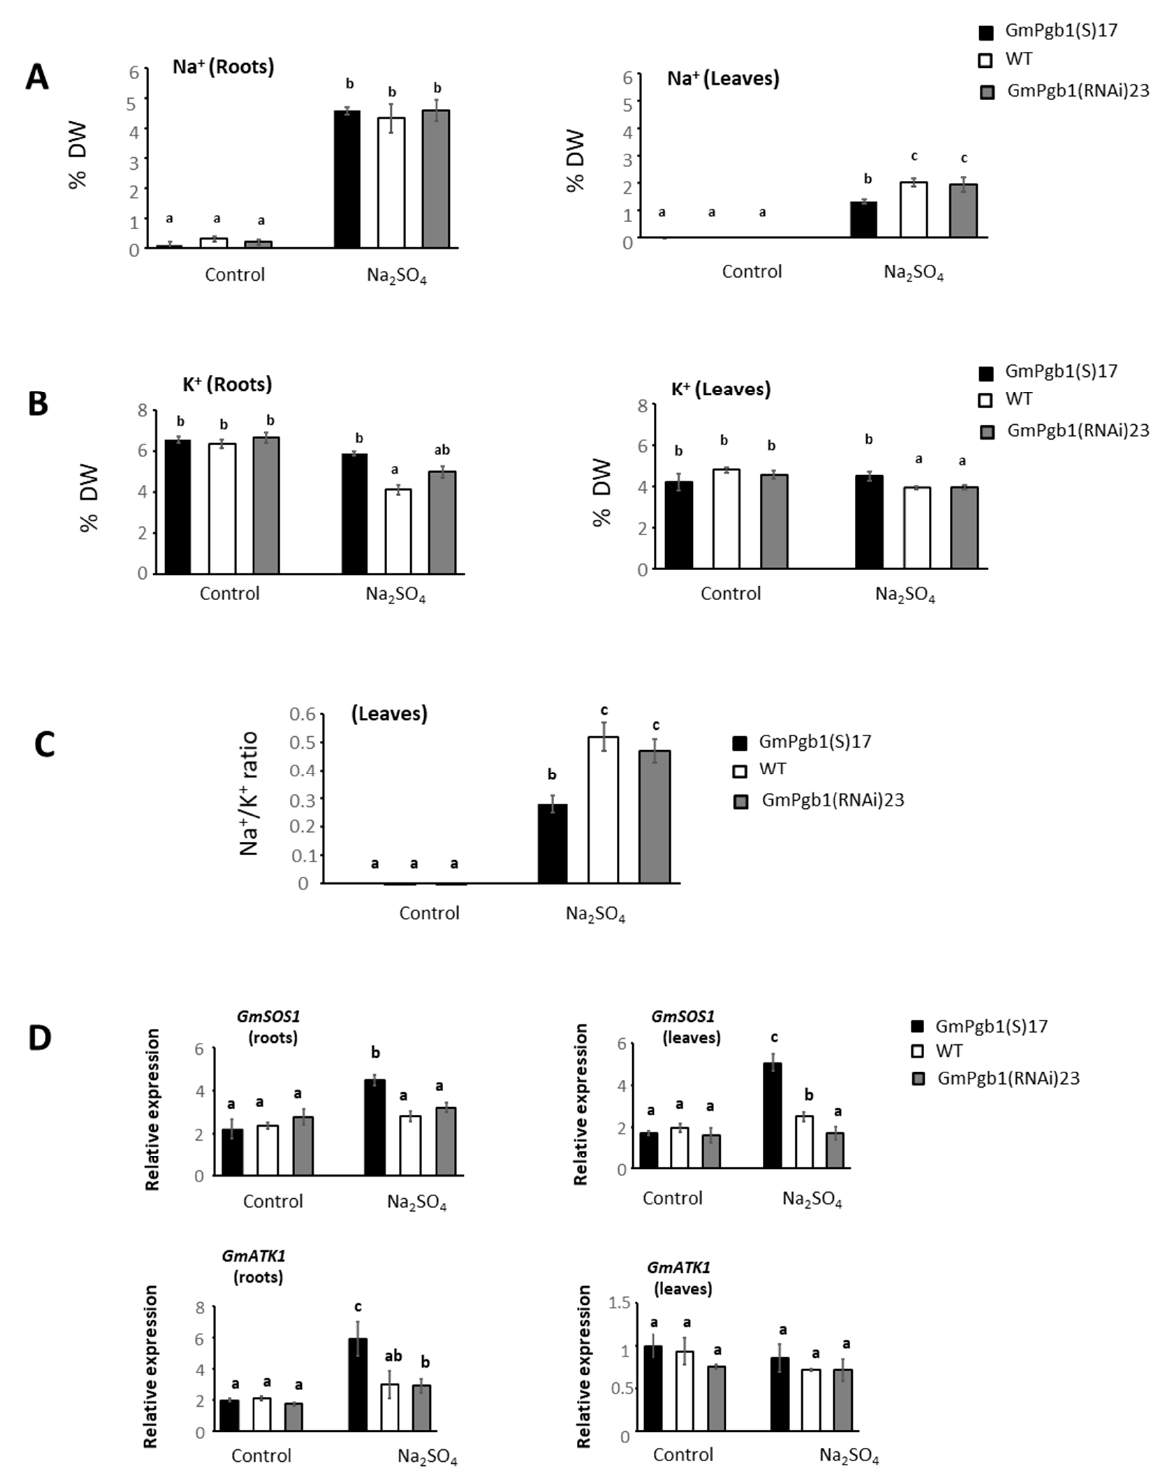
Figure 4. Levels of Na + ( A ), K + ( B ), and Na + /K + ratio ( C ) in WT plants and plants overexpressing (GmPgb1(S)17) or downregulating (GmPgb1(RNAi)23) GmPgb1 . Values are the means ± SE of three biological replicates, each consisting of at least five plants. Letters indicate statistically significant differences ( p < 0.05). ( D ) Relative transcript levels of GmSOS1 and GmAKT1 in the same plants. To further understand the mechanisms for the differential accumulation of Na + and K + , we measured the expression of two key genes involved in Na + and K + transport: